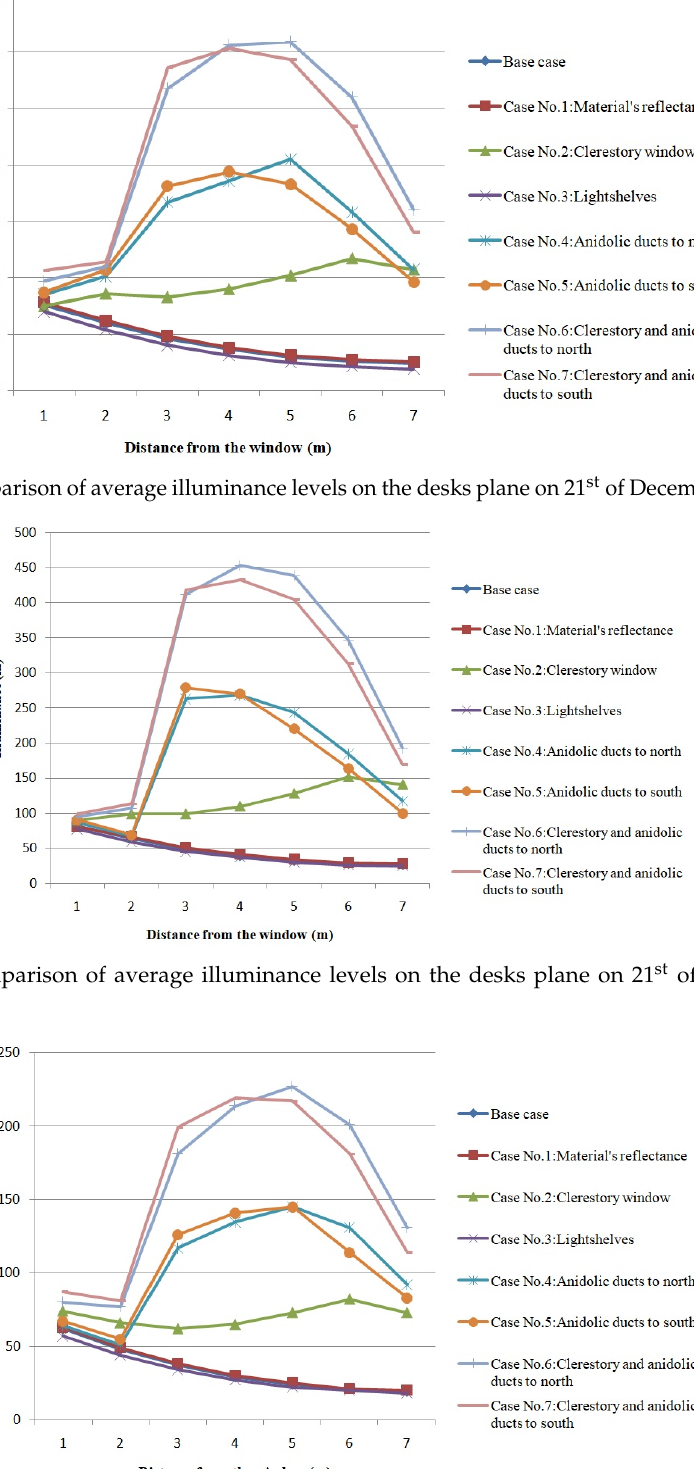
Figure 20. Comparison of average illuminance levels on the desks plane on 21 st of June at 3:00 pm.